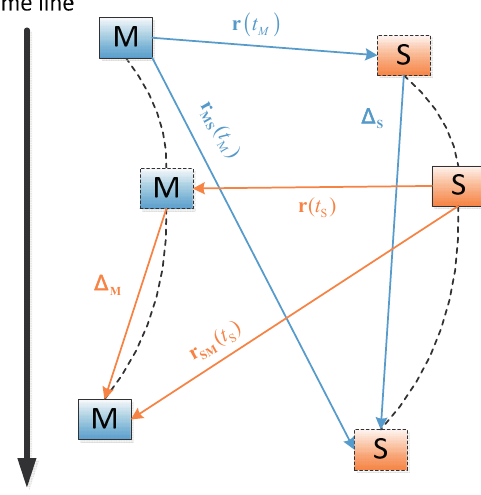
Figure 5. Changes of the position of the two satellites during the signal propagation